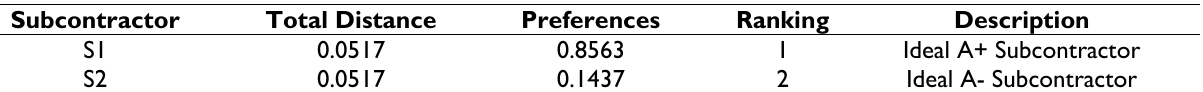
Table 6. Subcontractor preferences